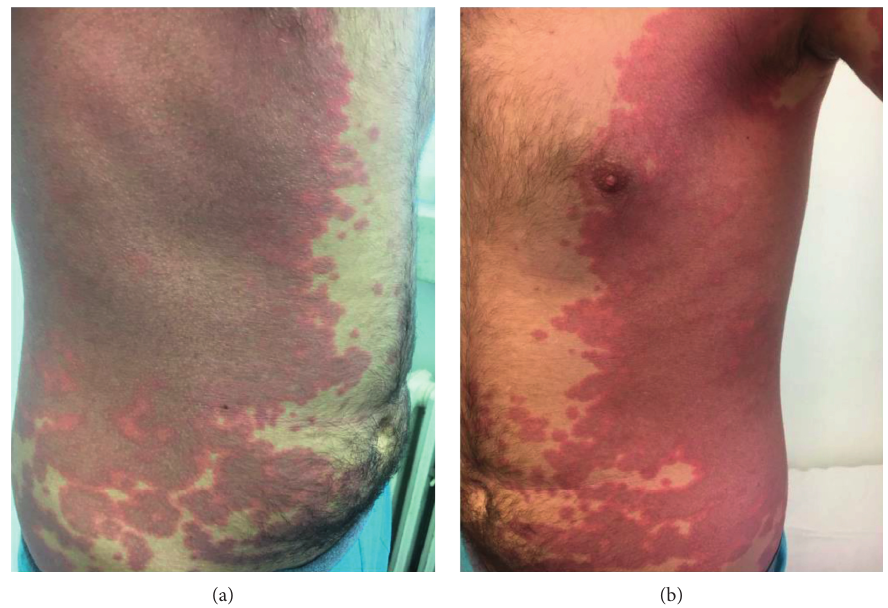
Figure 1: Very prominent skin rashes affecting the lateral parts of the body in both sides.